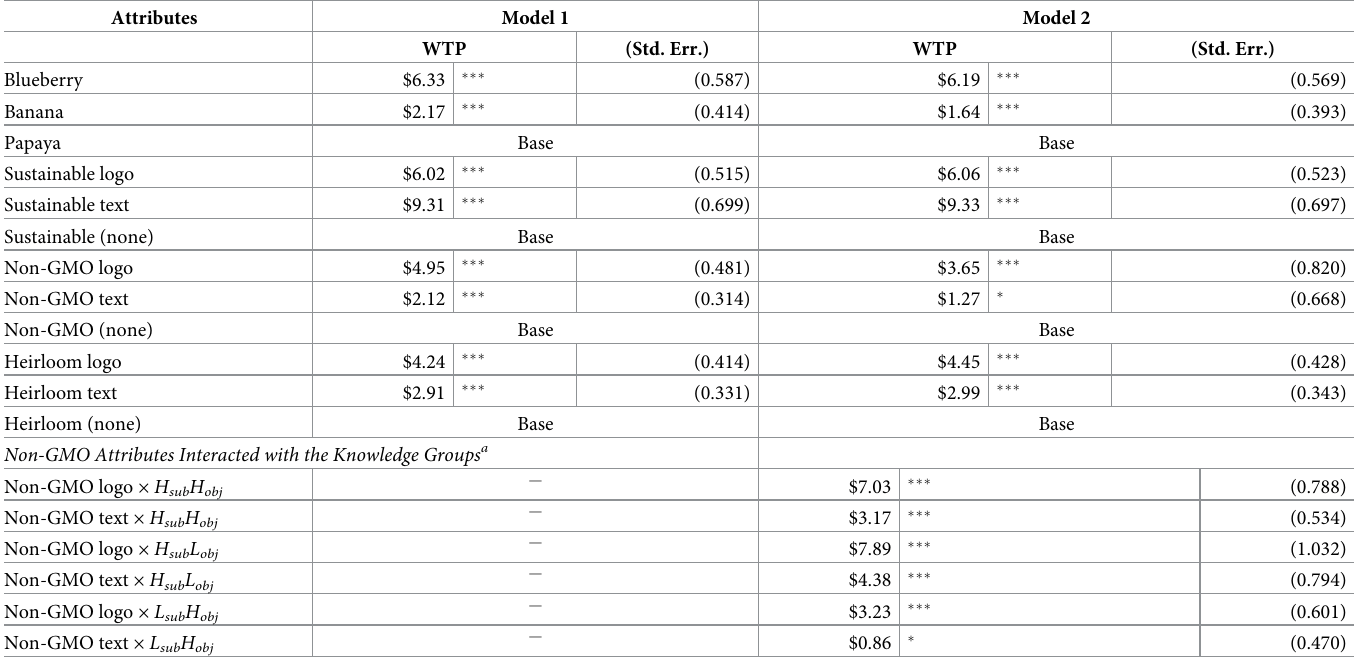
Table 4. Willingness-to-pay estimates from an online choice experiment (n =